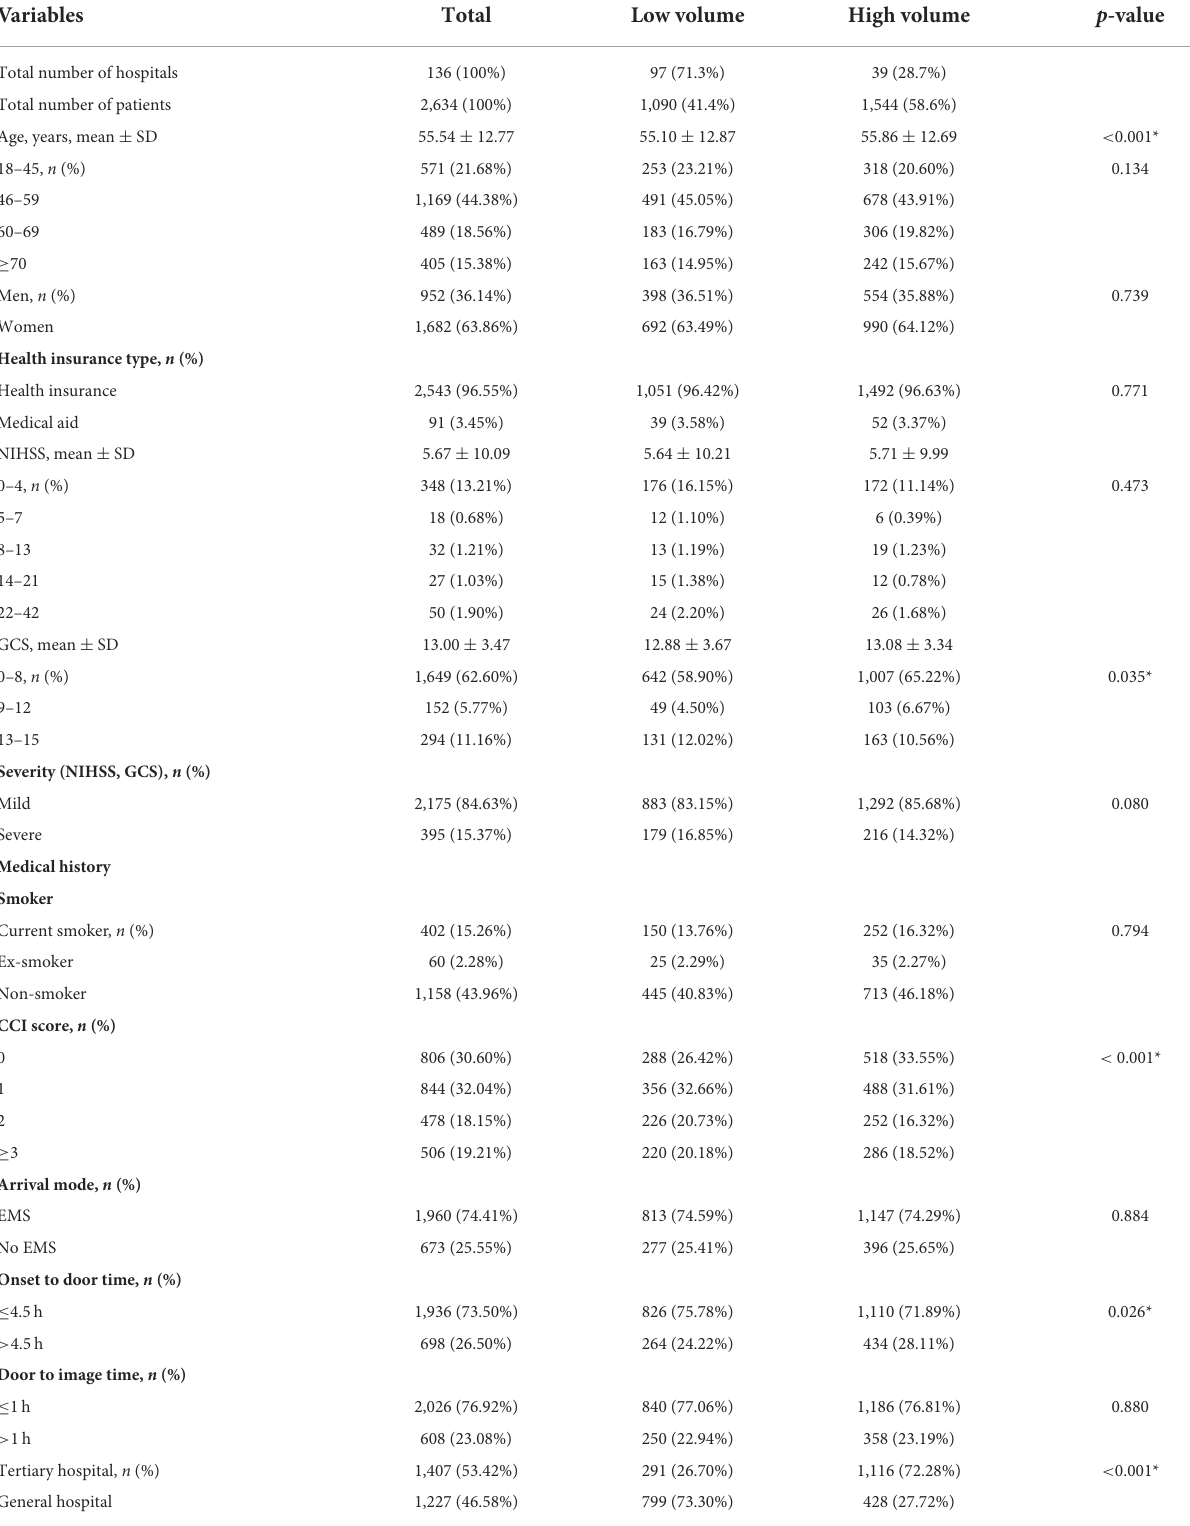
TABLE 1 Baseline characteristics of patients with subarachnoid hemorrhage who underwent clipping and